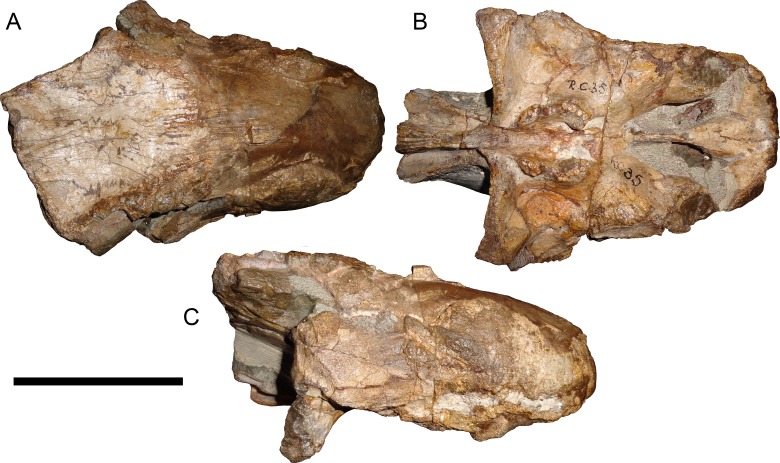
Referred specimen (RC 35) of Aelurognathus tigriceps (Broom & Haughton, 1913) in (A) dorsal, (B) ventral, and (C) right lateral view.Holotype of Leontocephalus cadlei
Broom, 1940b. Scale bar equals 10 cm.